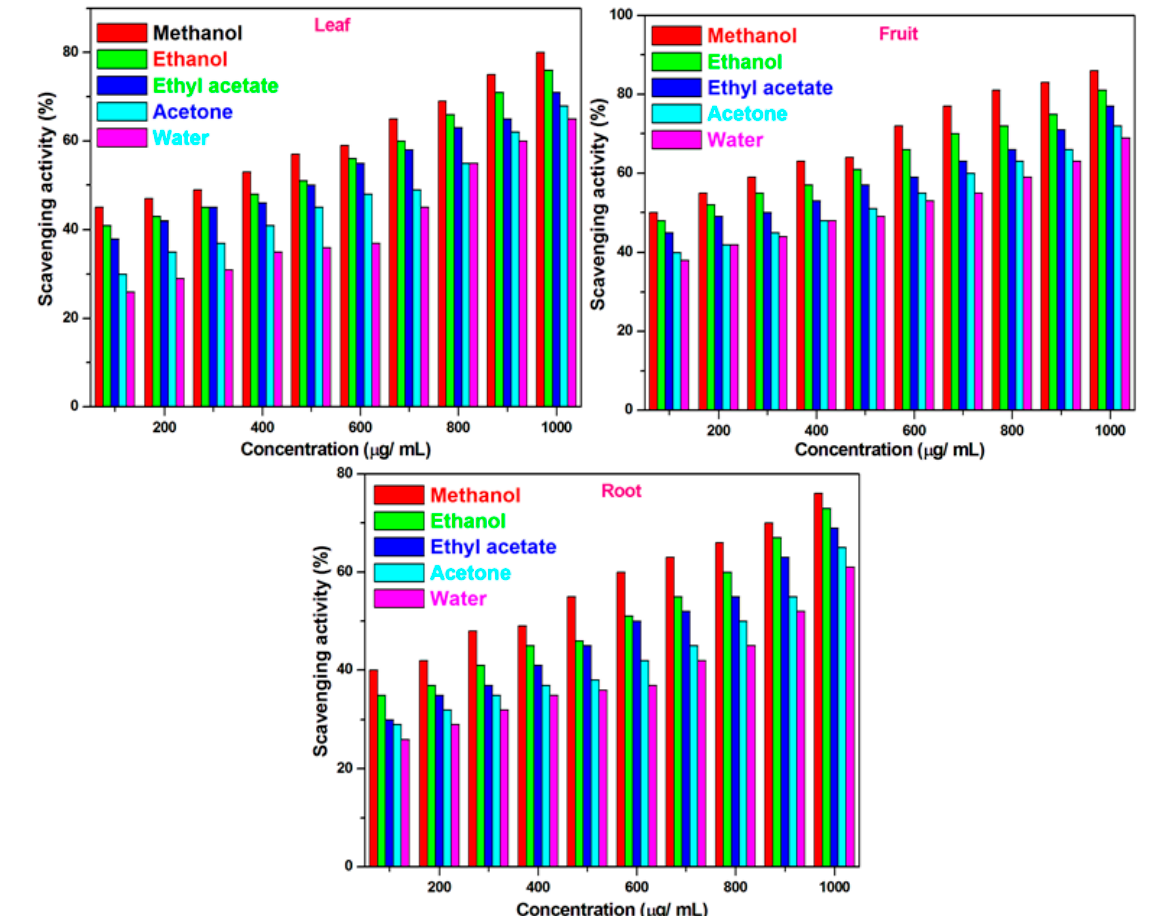
Figure 3. Hydrogen peroxide scavenging activity of P. ginseng.